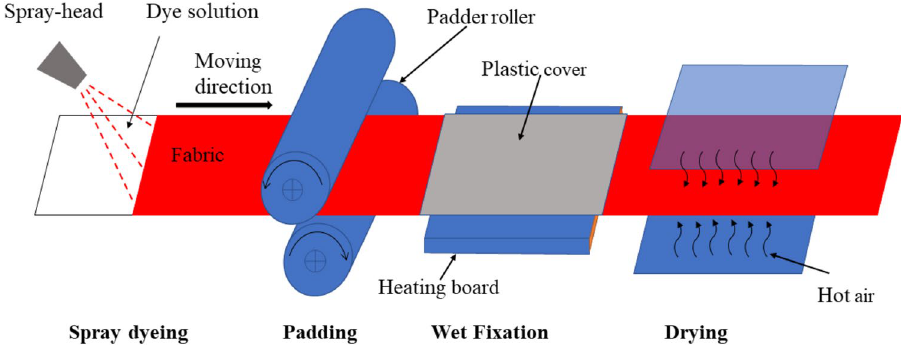
Figure 1. The schematic diagram of the spray dyeing process.